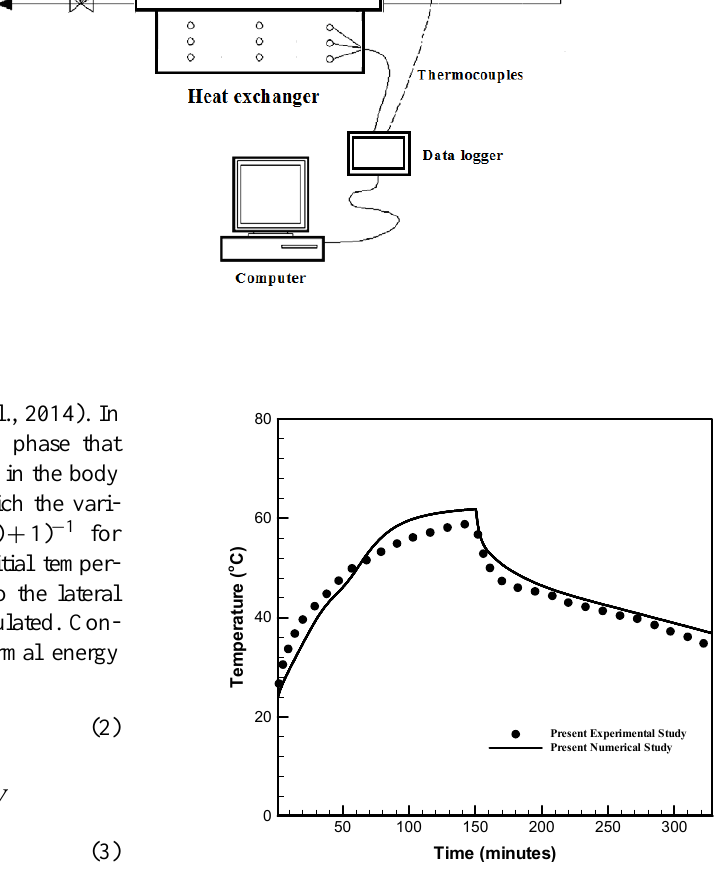
Figure 4. Comparison between numerical and experimental